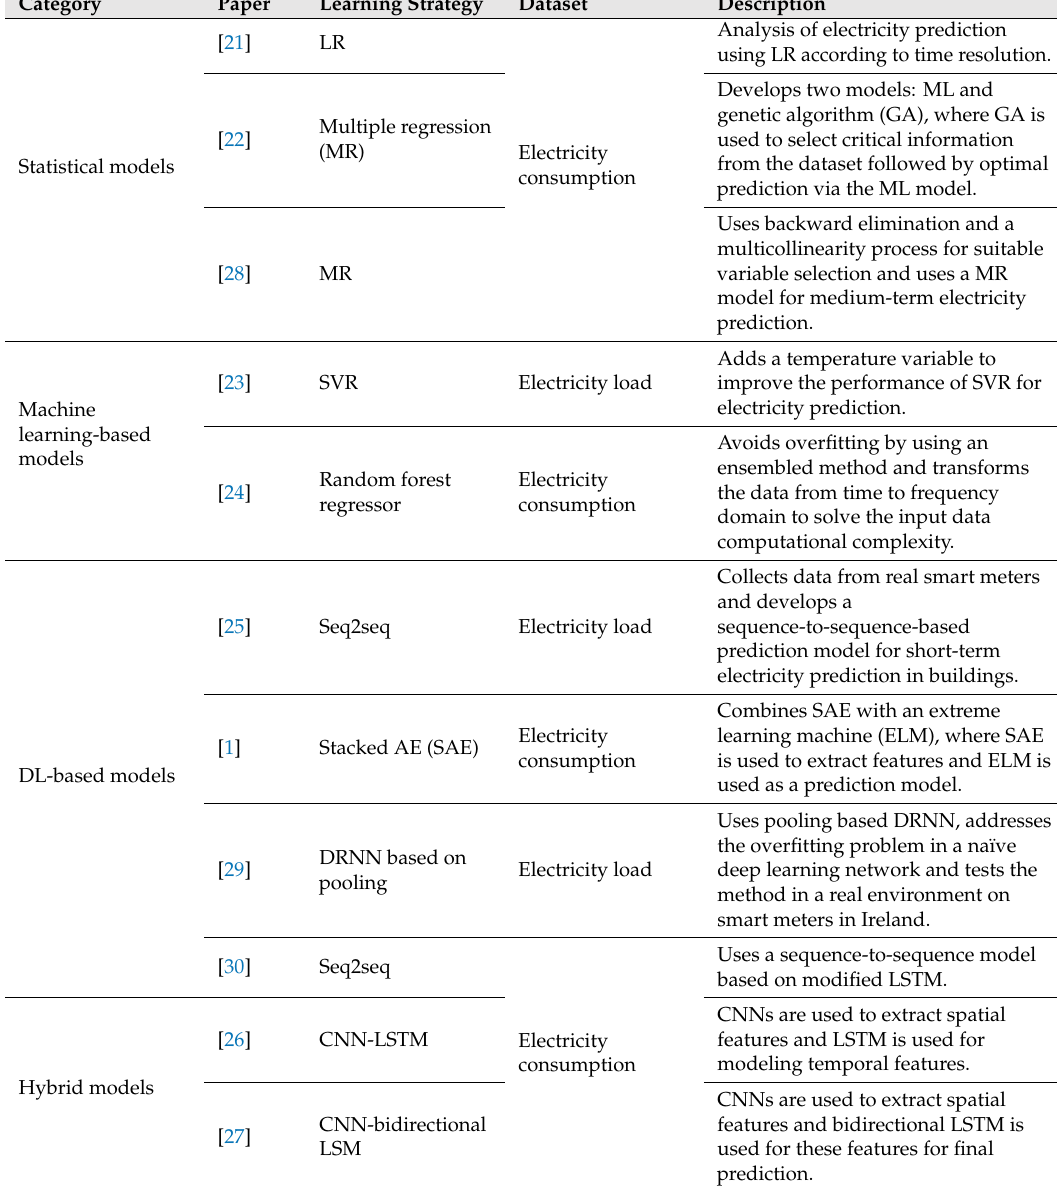
Table 1. The four types of prediction models for energy